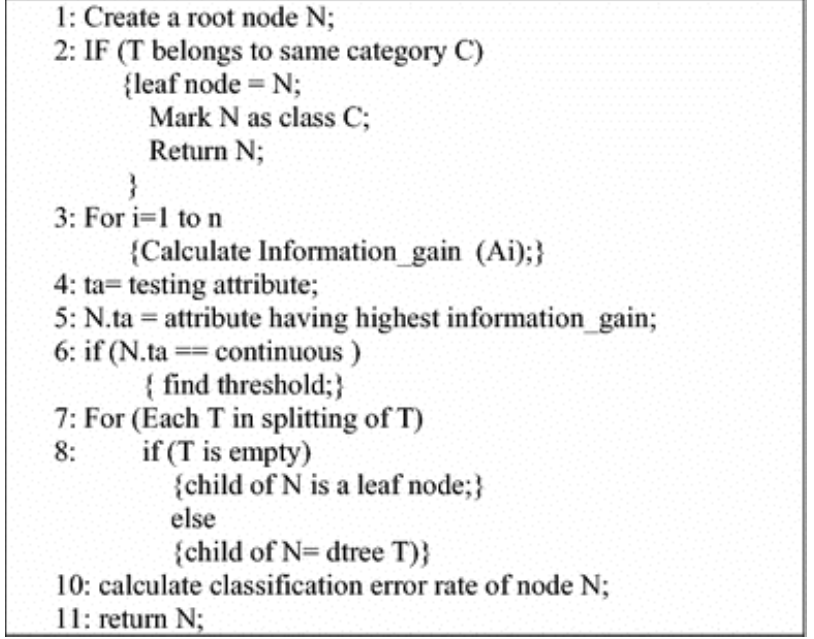
Figure 3. Pseudocode of C4.5 algorithm [26].